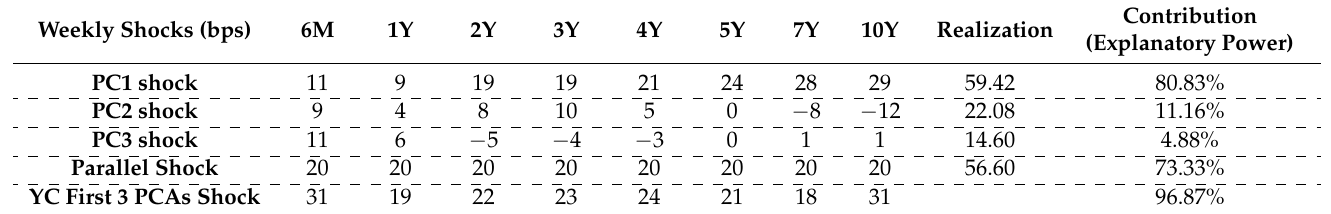
Table 4. One-standard-deviation PCA weekly yield curve shocks and corresponding explanatory powers on 25 March